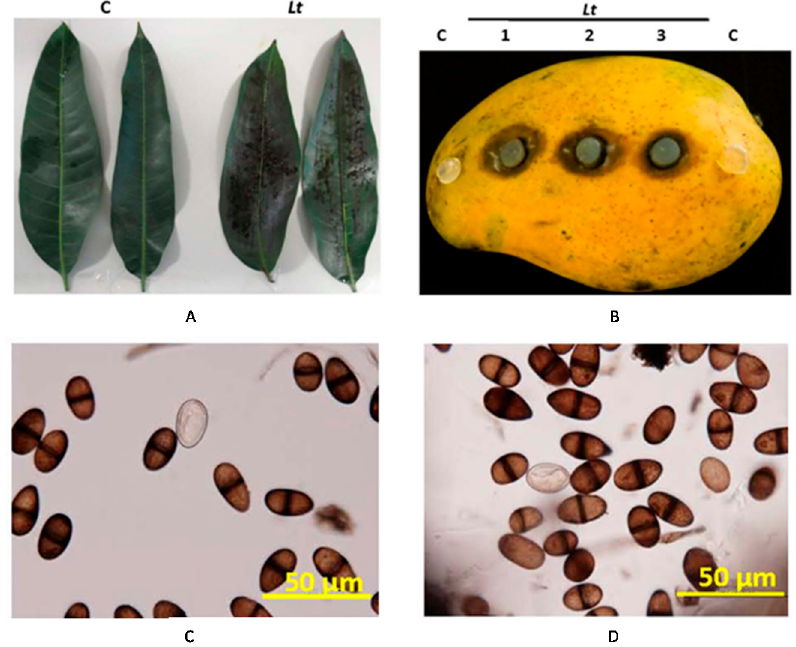
Figure 3. Pathogenicity assays of L. theobromae on mango leaves and fruits. Pathogenicity tests on inoculated (right) and non-inoculated (left) of ( A ) detached mango leaves; and ( B ) mango fruits, at 5 dpi. Conidia of the pathogen from the inoculated mango ( C ) leaves; and ( D ) fruits. C, control (no L. theobromae ); Lt , L. theobromae .